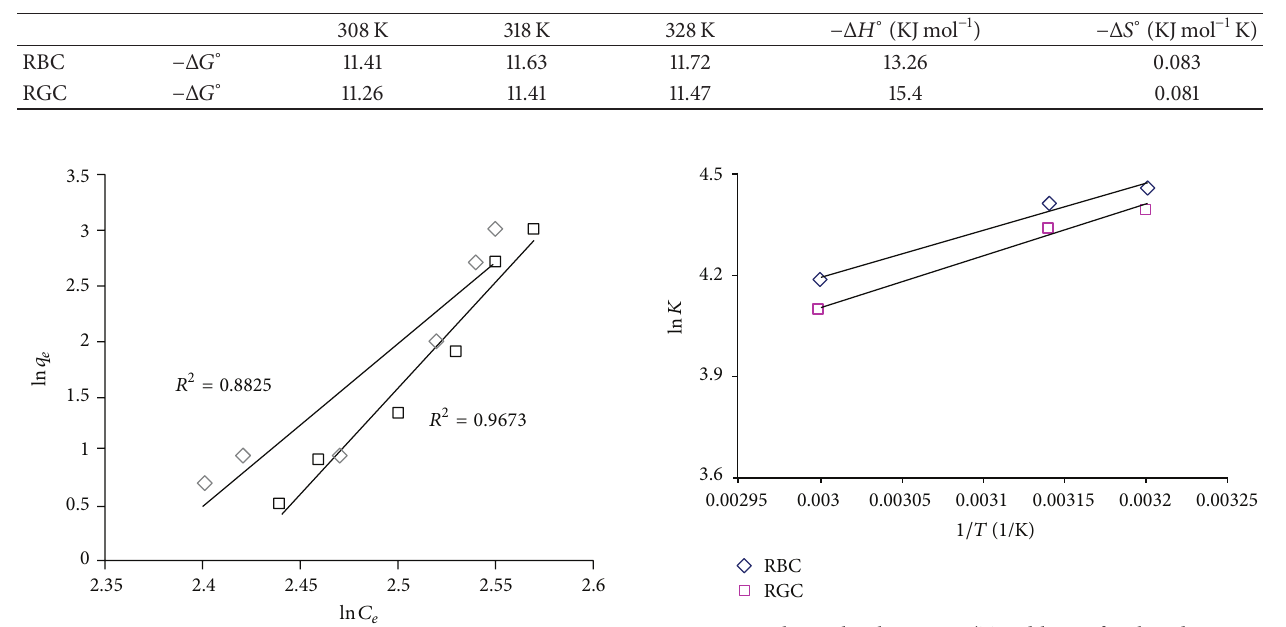
Figure 9: Relationship between 1/𝑇 and ln 𝐾 𝑑 for the adsorption of OM on the studied samples ( 𝑉 𝑆/𝐿 = 20 g/L; 𝑇 : 35 ∘